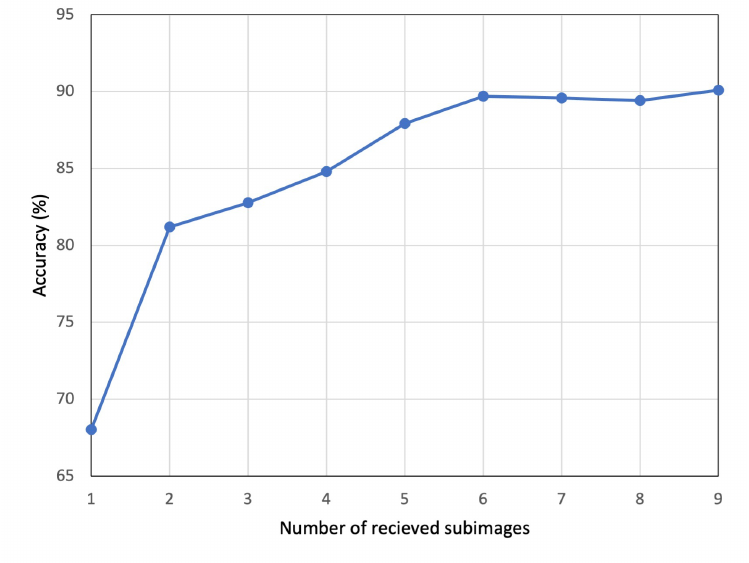
Figure 7. Average recognition accuracy trend with increase in number of subimages